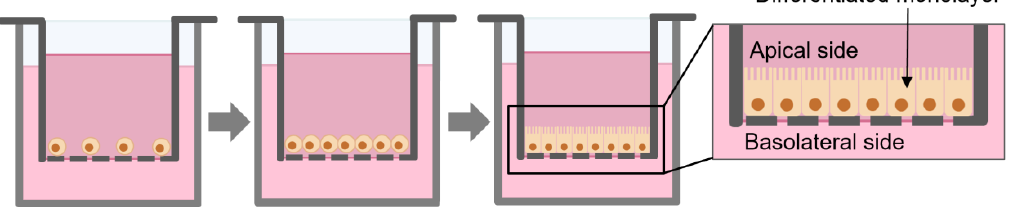
Figure 1. Scheme of the growth and differentiation of Caco-2 monolayer in permeable